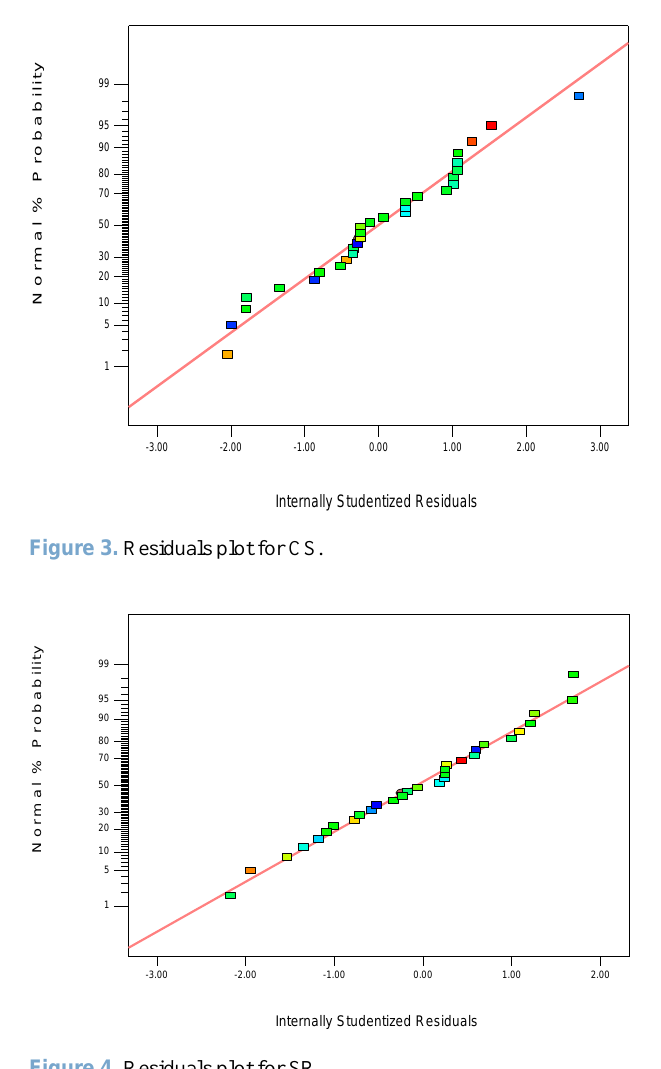
Figure 3 Residuals plot for CS